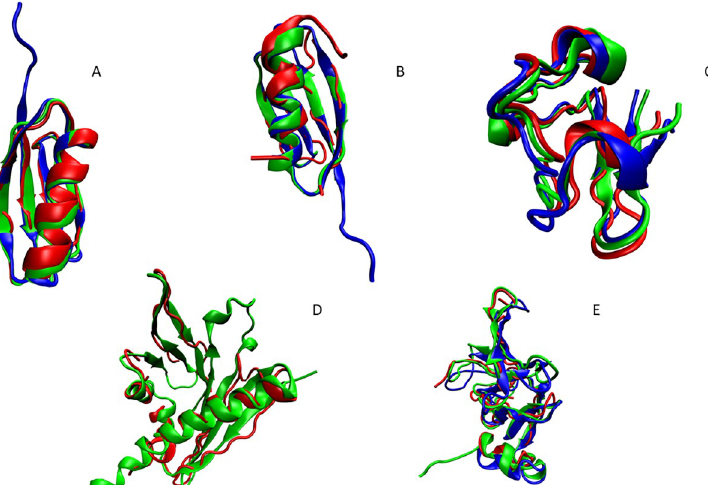
Fig 1. Results of REDCRAFT structure calculation (in red) compared to X-ray crystal structures (in blue) and, where applicable, traditional NMR structures (in green) for A) GB1, B) GB3, C) Rubredoxin, D) ChR145, and E) SR10.